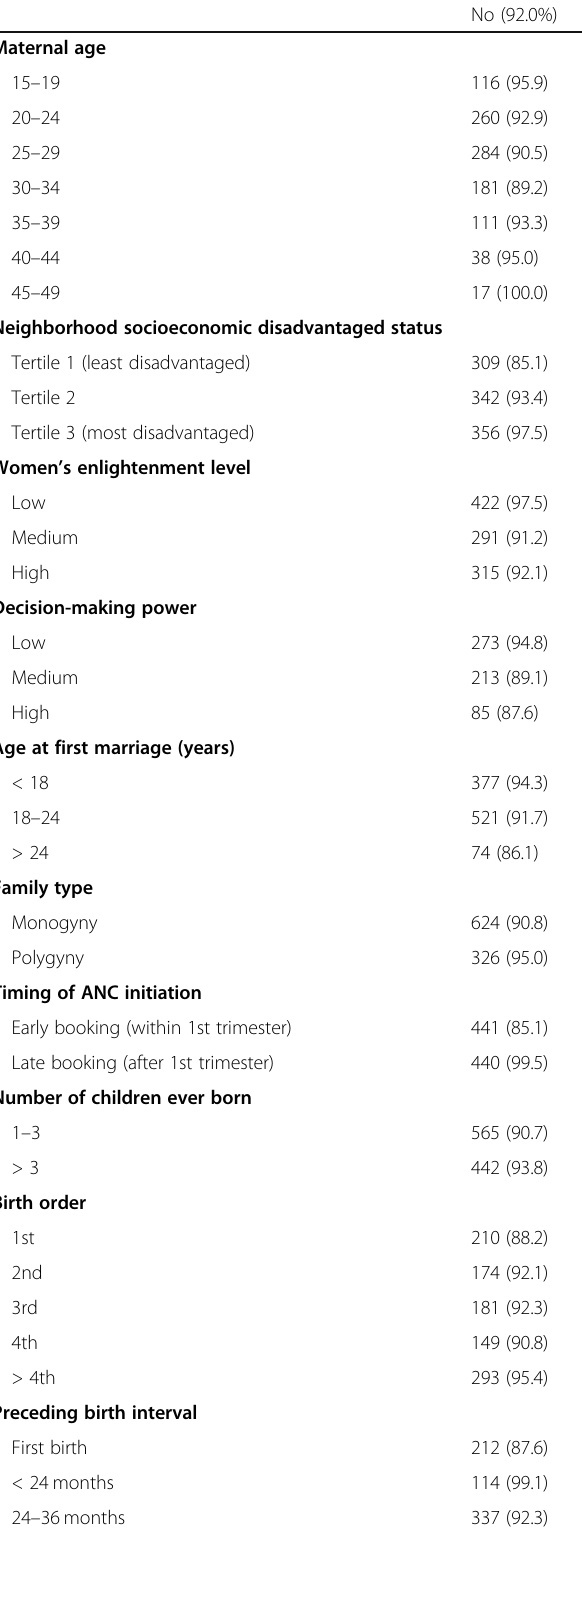
Table 1 Characteristics of women attending ≥ 8 ANC contacts in Benin, West Africa, BDHS 2017 – 18